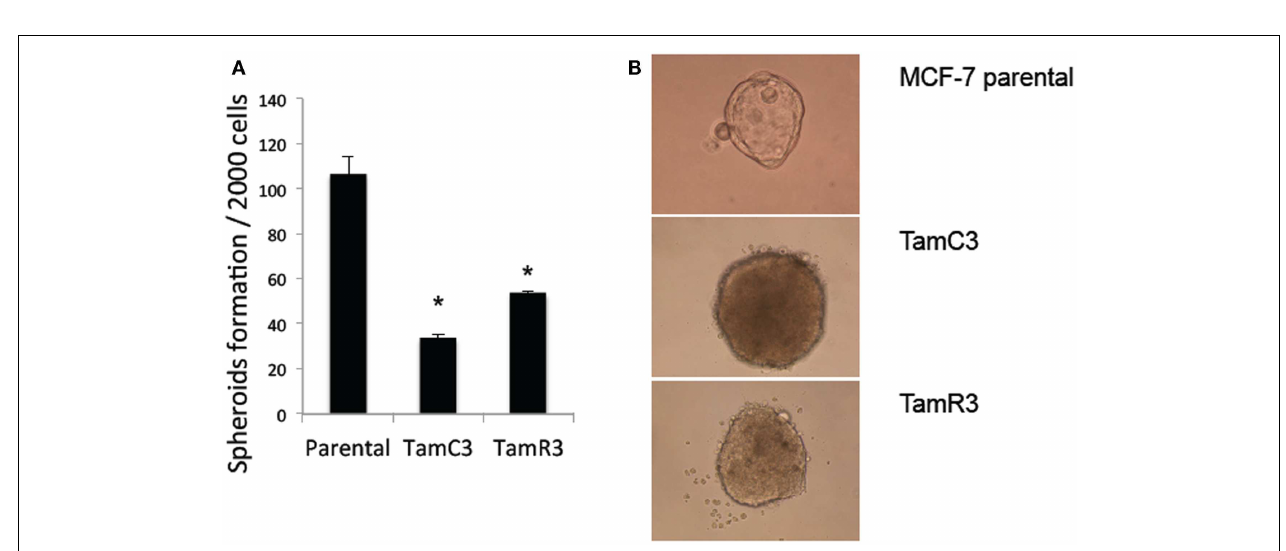
FIGURE 6 | Comparison of cellular energy utilization . (A) Uptake of 2-deoxy-d-[1- 3 H]glucose by MCF-7 parental,TamC3, andTamR3 cells. (B) Lactate concentration in culture medium of MCF-7 parental,TamC3, orTamR3 cells, measured spectrophotometrically. (C) Metabolic rate of MCF-7 parental,TamC3, andTamR3 cells, as measured by Alamar Blue assay. (D) ROS concentration in MCF-7 parental,TamC3, andTamR3